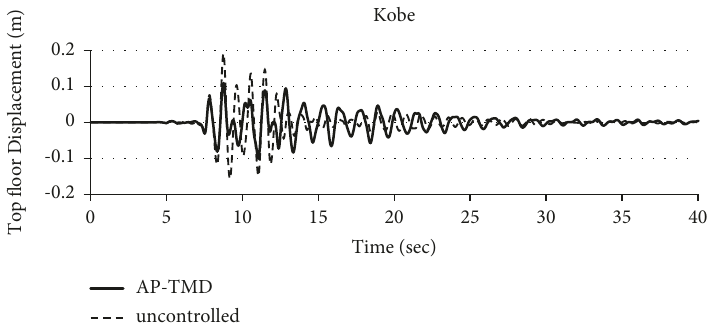
Figure 17: Top floor displacement of structure under